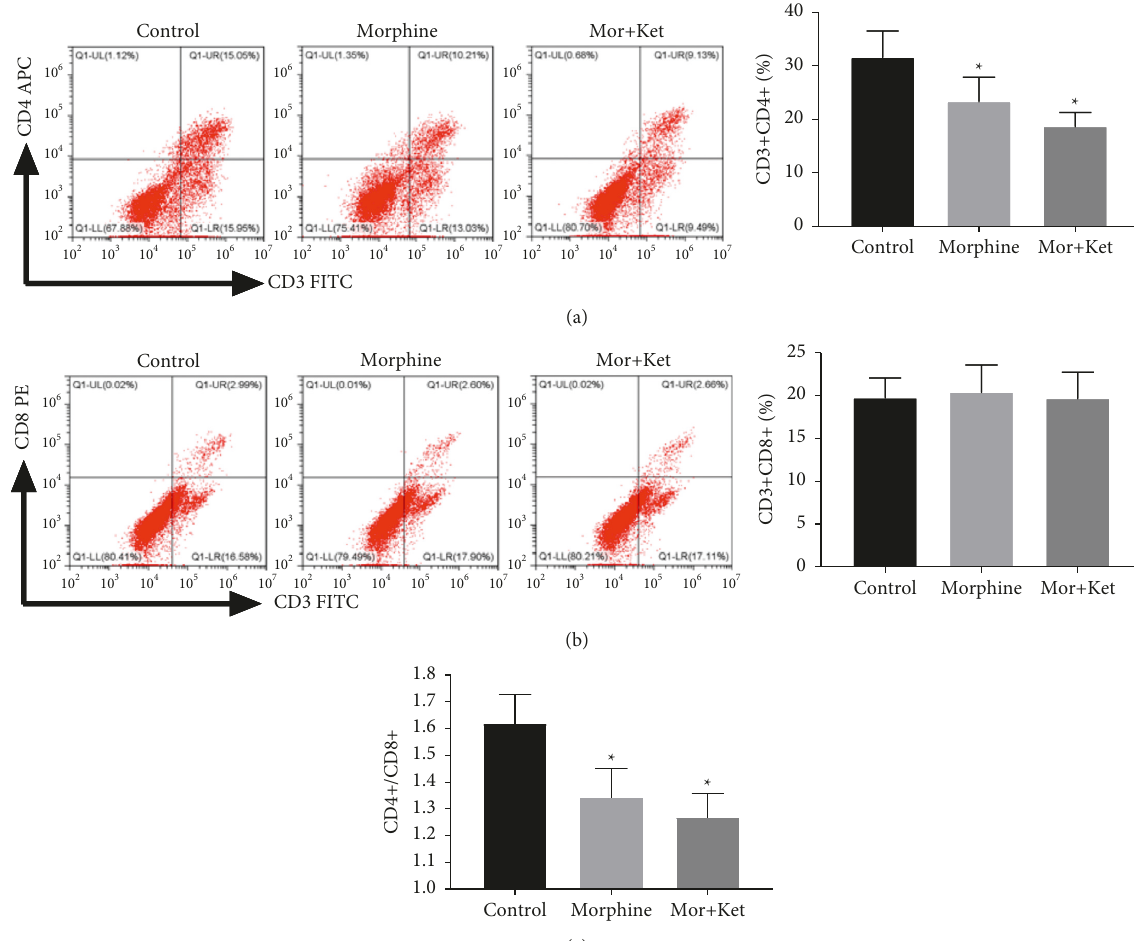
Figure 2: Morphine combined with ketamine decreases CD4 + /CD8 + ratio in vitro. (a) The percentage of CD4 + assessed by flow cytometry analysis. (b) The percentage of CD8 + assessed by flow cytometry analysis. (c) Analysis for CD4 + /CD8 + ratio. ∗ P < 0 . 05 vs. the control